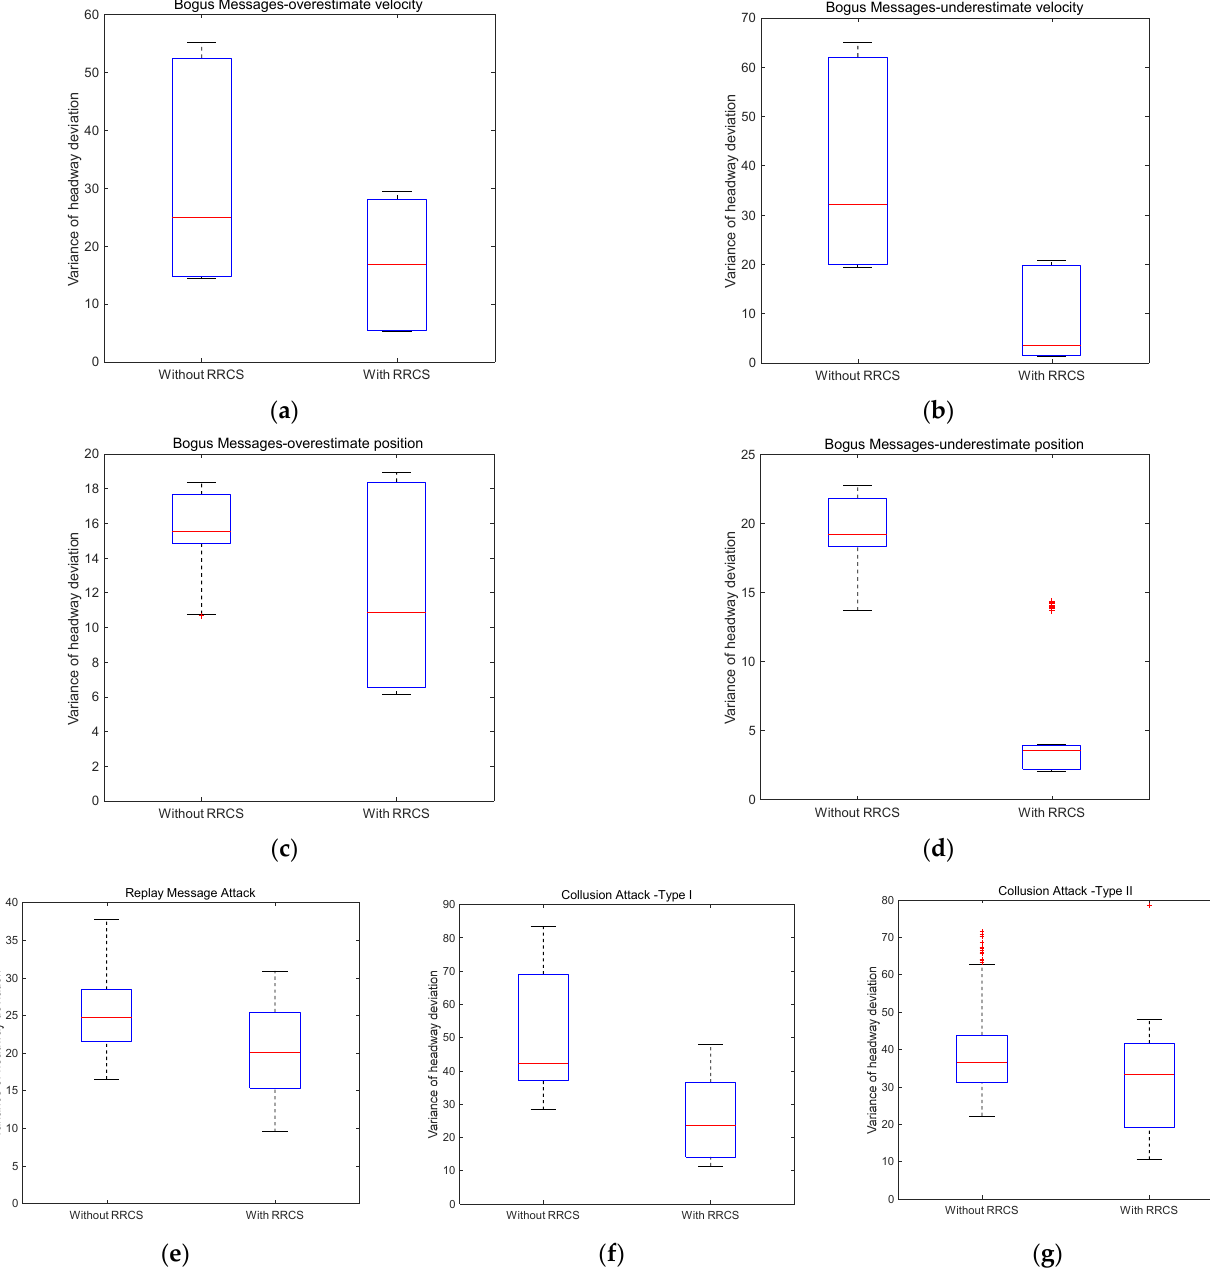
Figure 10. Variance distribution of headway deviation under different cyberattacks scenarios with different vehicle proportion and distribution. Table 4. Box plot data of variance distribution of headway deviation with or without RRCS under different vehicle proportion and vehicle distribution.